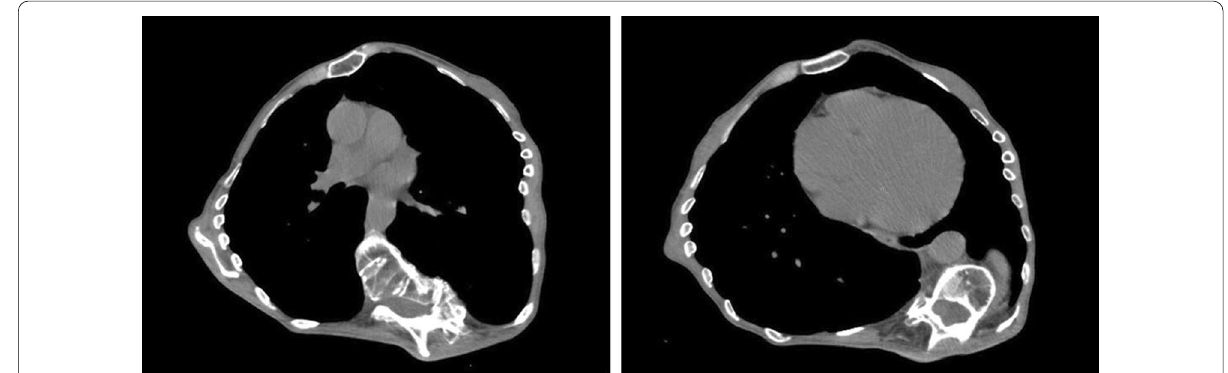
Fig. 2 Preoperative chest computed tomography showing deformity of the pleural cavity and distortion of spine